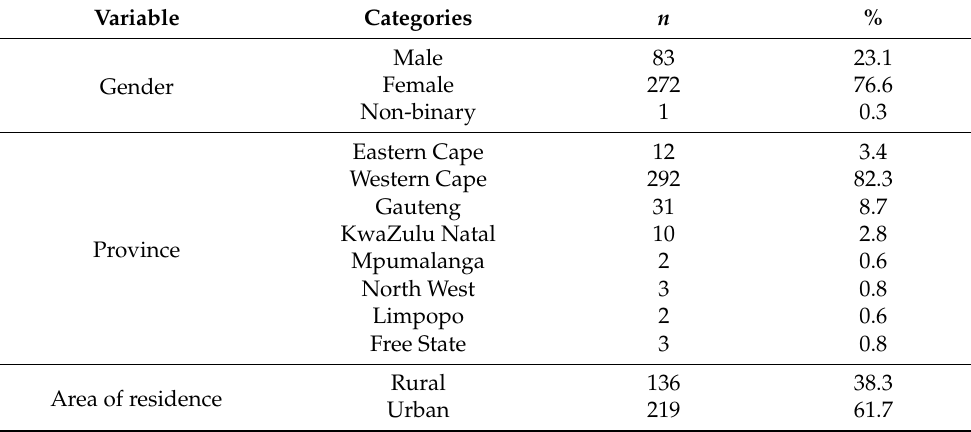
Table 1. Demographic description of the